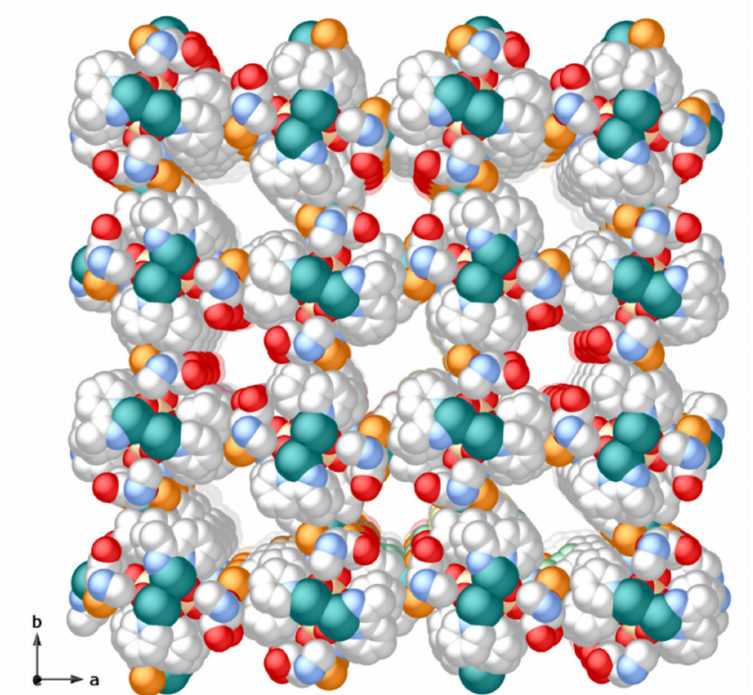
Figure 4. Perspective view along the c crystallographic axis of a fragment of CMP MOF 1 porous structure as a space-filling model (atoms are represented with van der Walls radii). Alternating hydrophobic and hydrophilic nanopores exhibit virtual diameters of 1.2 and 0.8 nanometers, respec- tively. Color scheme: copper, cyan; phosphorous, orange; oxygen, red; nitrogen, blue; carbon, grey; bromide, brown. Hydrogen atoms and lattice water molecules have been omitted for the sake of clarity.